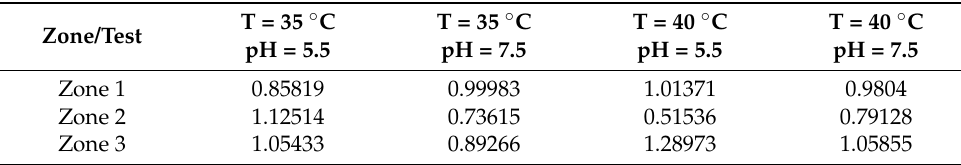
Table 2. Hurst exponent by zone for the four experimental